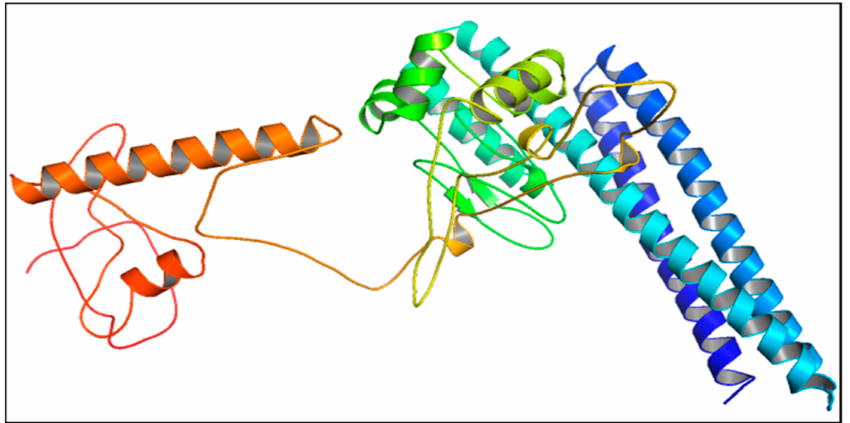
Figure 6. Predicted 3D structure of T. pallidum vaccine constructs, visualized by Pymol